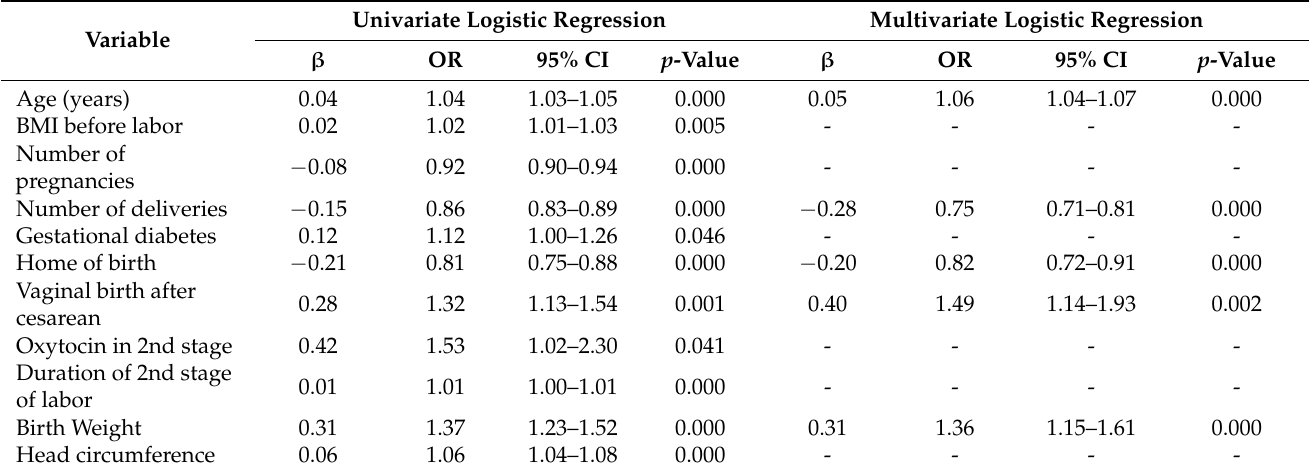
Table 4. Logistic regression models of risk factors for perineal trauma during